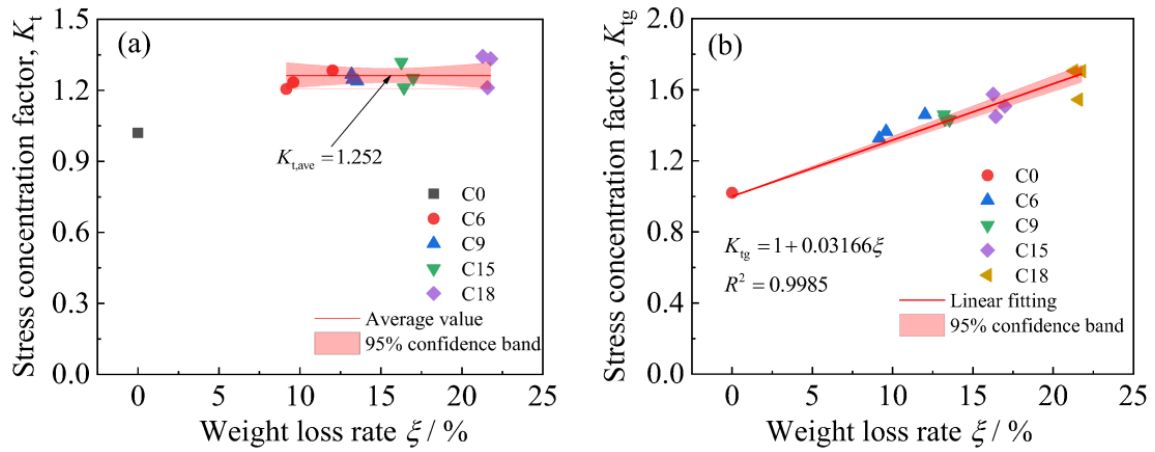
Figure 14. Effect of corrosion duration on the stress concentration of the unpatched corroded steel plate: ( a ) K t , ( b ) K tg .